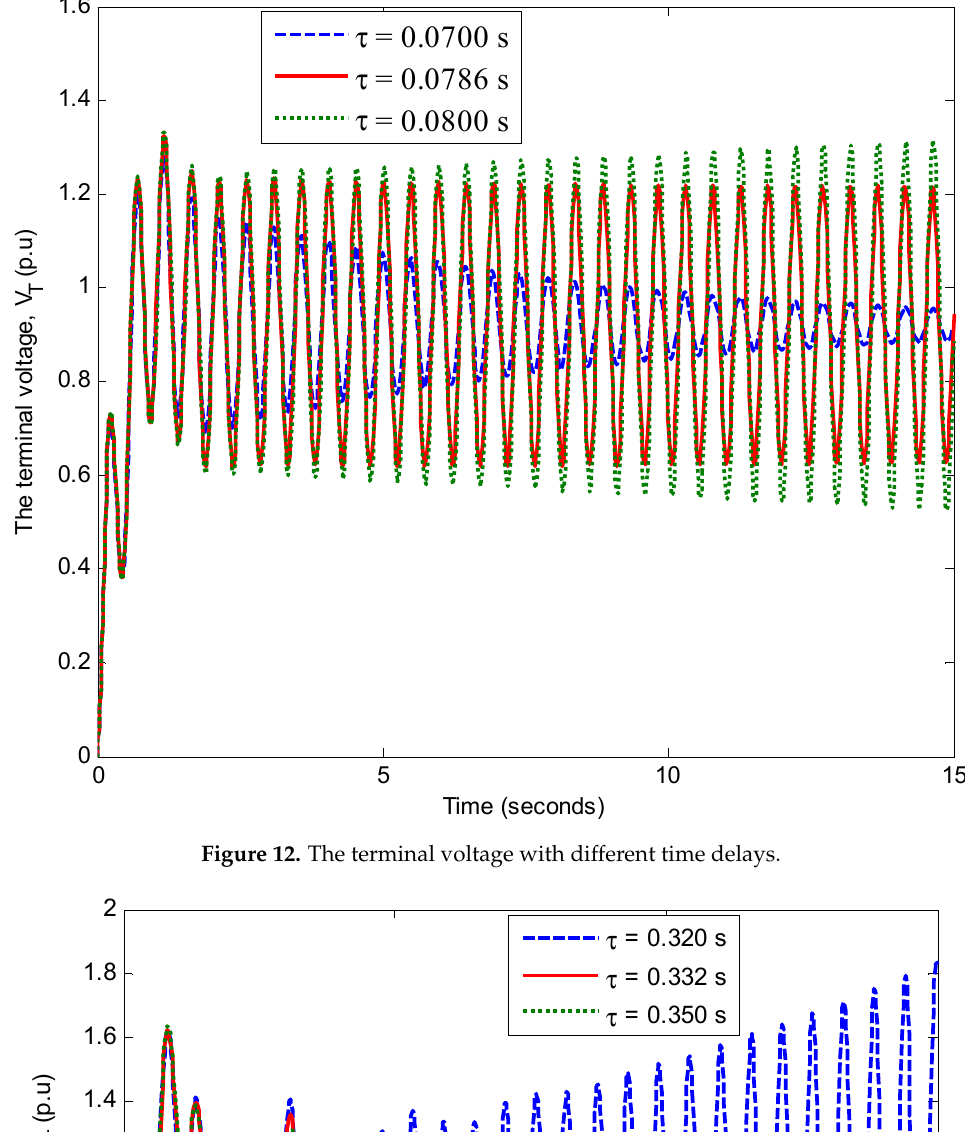
Figure 11. The spectral radius as function of ω .